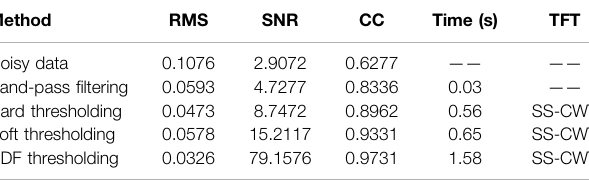
Frontiers in Earth Science |